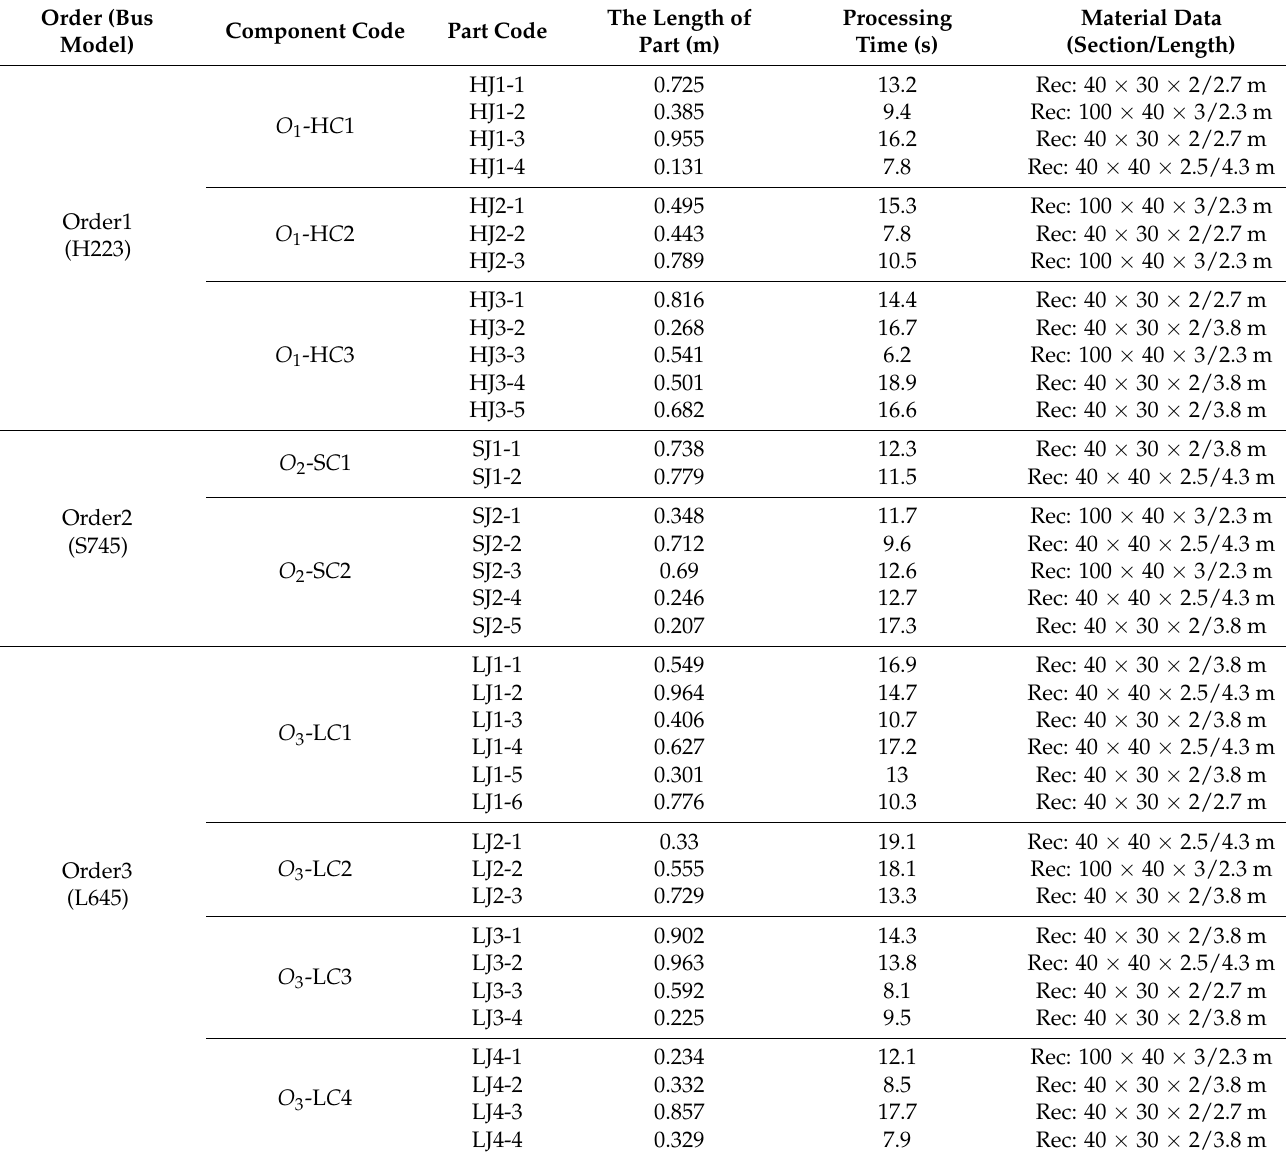
Table 1. Order data of simplified real